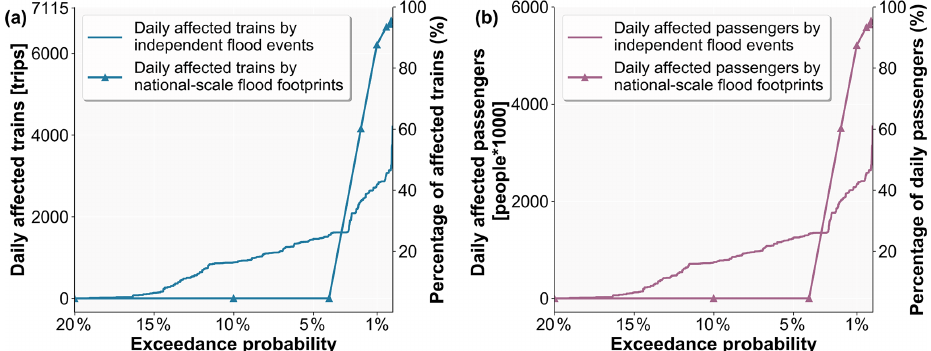
Figure 9. Performance loss for the Chinese railway system using national-scale flood footprints of (a) daily affected trains and (b) daily affected